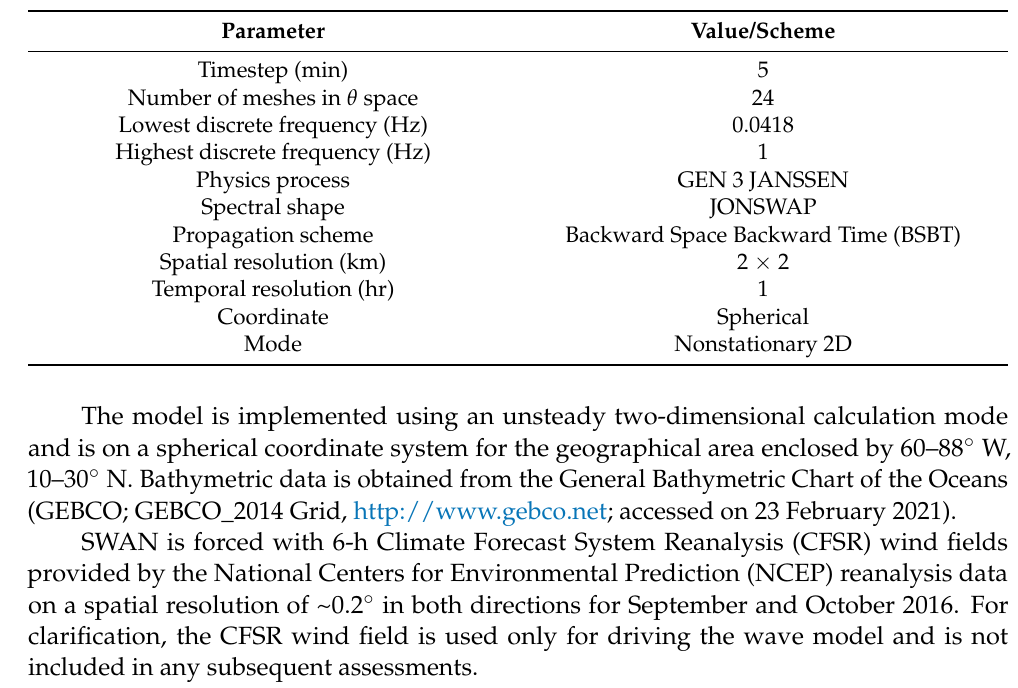
Table 2. Simulating WAves Nearshore model